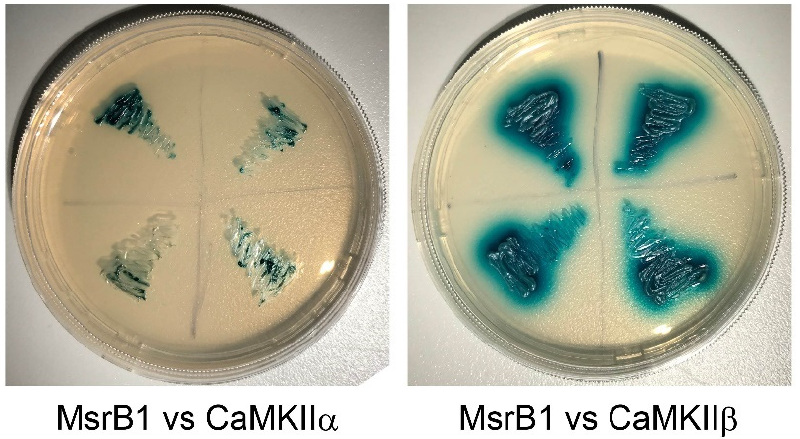
Figure 2. The interaction of MsrB1 with CaMKII α and CaMKII β demonstrated by yeast two-hybrid screening.